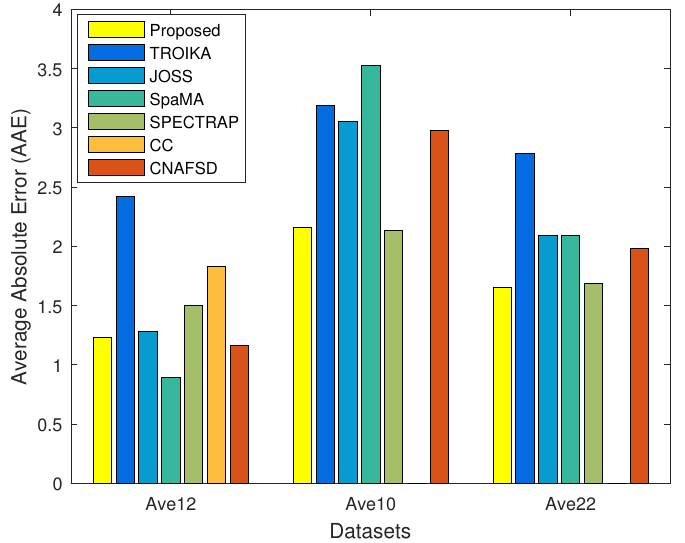
Figure 4. The bar graph of HR estimation results for the approaches listed in Table 1 (the proposed HR estimation approach, TROIKA [15], JOSS [30], SpaMA [31], SPECTRAP [20], CC [13] and CNAFSD [14]) in terms of average AAEs on the first 12 recording, the remaining 10 challenging recordings and all 22